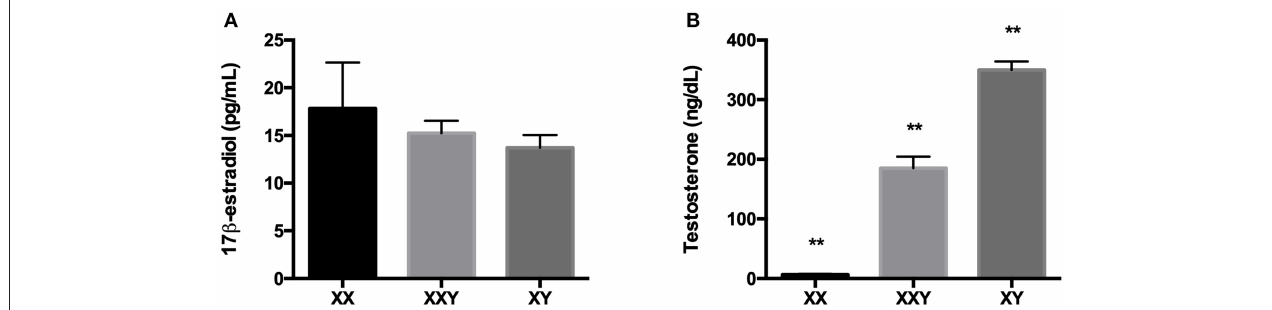
FIGURE 6 | Mean ± SEM of the levels of 17 β -estradiol (A) and testosterone (B) in the serum of women (XX), subjects with Klinefelter syndrome (XXY), and men (XY). Sex steroids were measured in serum by direct radioimmunoassay (RIA). (** p < 0.01 using one-way ANOVA for independent groups with n = 17).